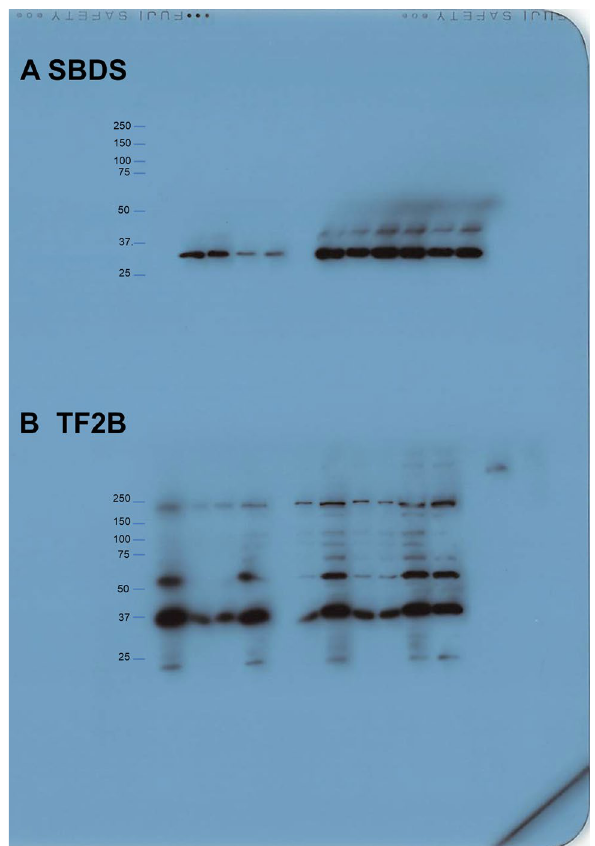
Figure 3. A correct version of the original Western blots for Figure 2b in the Supplementary Information